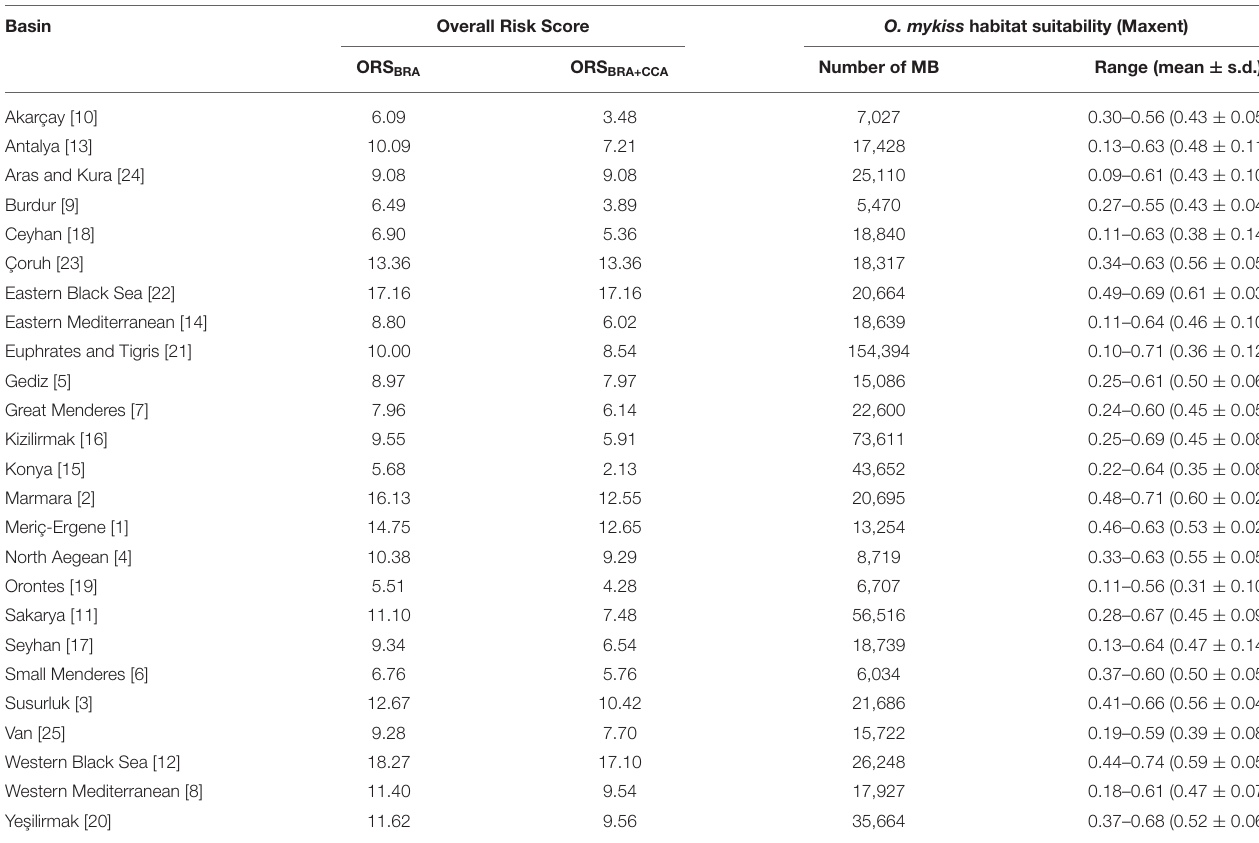
TABLE 2 | Overall Risk Score (ORS) of the river basins calculated based on their mean Oncorhynchus mykiss habitat suitability values (Maxent) and the Basic Risk Assessment (ORS BRA ) and Climate Change Assessment (ORS BRA + CCA ) scores. MB,